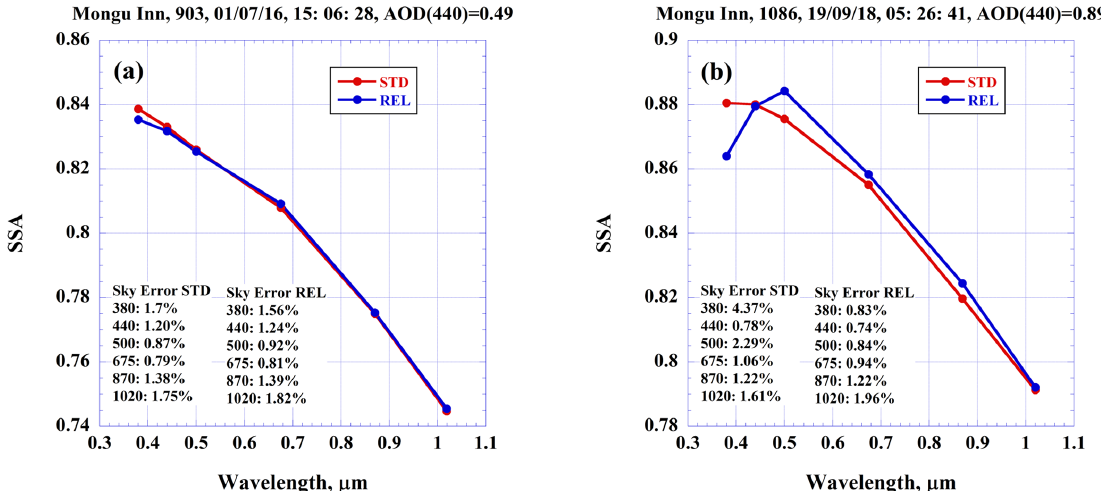
Figure 2. SSA retrieved using V3 assumptions on the IPRI smoothness constants (STD) and that of relaxed constraints (REL) at Mongu Inn AERONET site: (a) AOD(440) = 0.49, AE = 1.85 and (b) AOD(440) = 0.89, AE = 1.97.